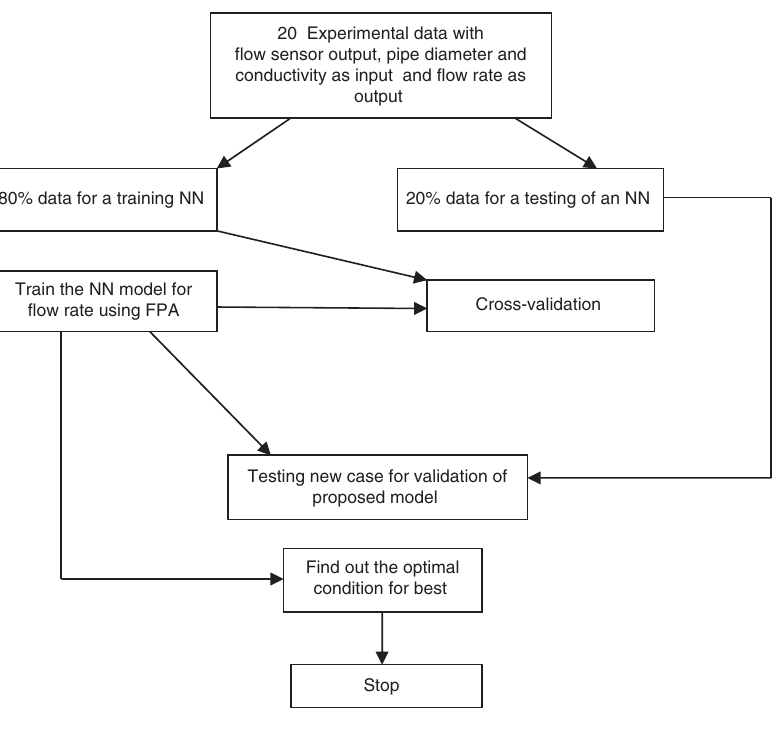
Figure 6: Flowchart of the Proposed